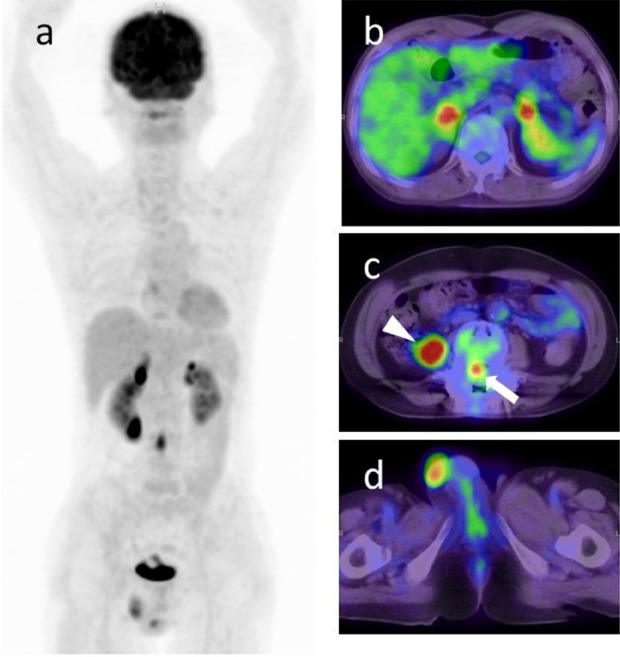
A 59-year-old man with lymphoma;(a) Maximum intensity projection image and (b-d) fused FDG-PET/CT images are shown. The patient presented with motor and sensory disturbance of the bilateral lower limbs for six months. FDG-PET/CT showed multiple lesions in bilateral adrenal glands (b) (SUVmax=17.1 in the right, and 8.8 in the left), cauda equine (c; white arrow) (SUVmax=7.9 at the level of L3), right retroperitoneum (c; white arrowhead) (SUVmax=14.3), and bilateral testes (d) (SUVmax=6.1 in the right, and 4.9 in the left) with elevated FDG uptake. Elevated sIL-2R of 1680 U/ml was also observed. Given the distribution and extremely elevated FDG uptake of lesions, the evaluators commented that lymphoma was most strongly suspected. On the other hand, although they considered that a case without any nodal metastases but with distant metastases as stated above is very rare, metastatic testicular tumor was also added to differential diagnosis (degree of suspicion was Grade 2). Right orchiectomy was performed and confirmed diagnosis was diffuse large B-cell lymphoma